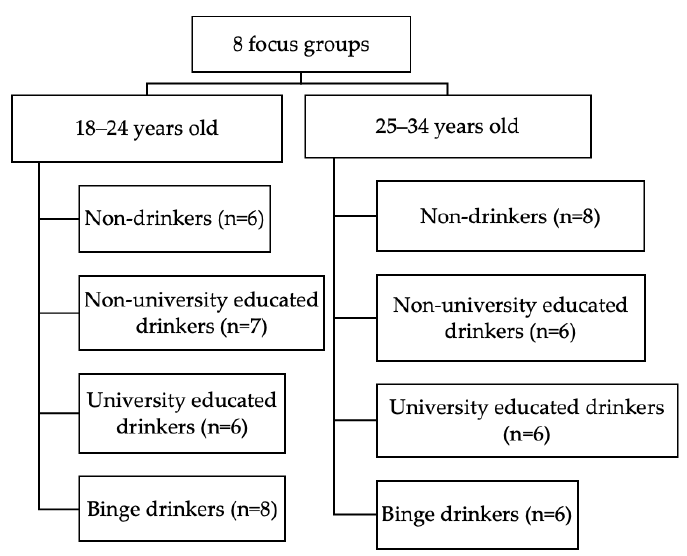
Figure 1. Number of focus groups conducted by age group and drinking category ( n =